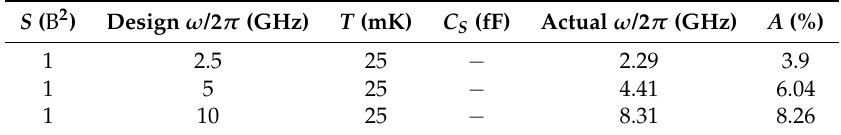
Figure 6. Contour plots of anharmonicity and qubit frequency versus temperature and qubit area. Table 1. Qubit designs with no series capacitor S = 1 mm 2 .